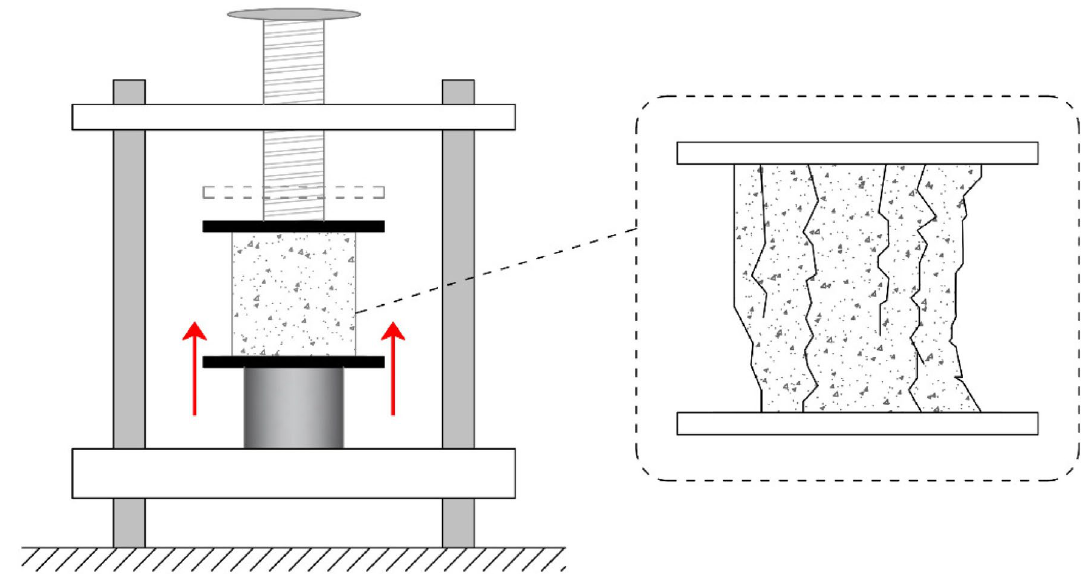
Figure 5. Schematic of compressive strength testing of the concrete mixture.